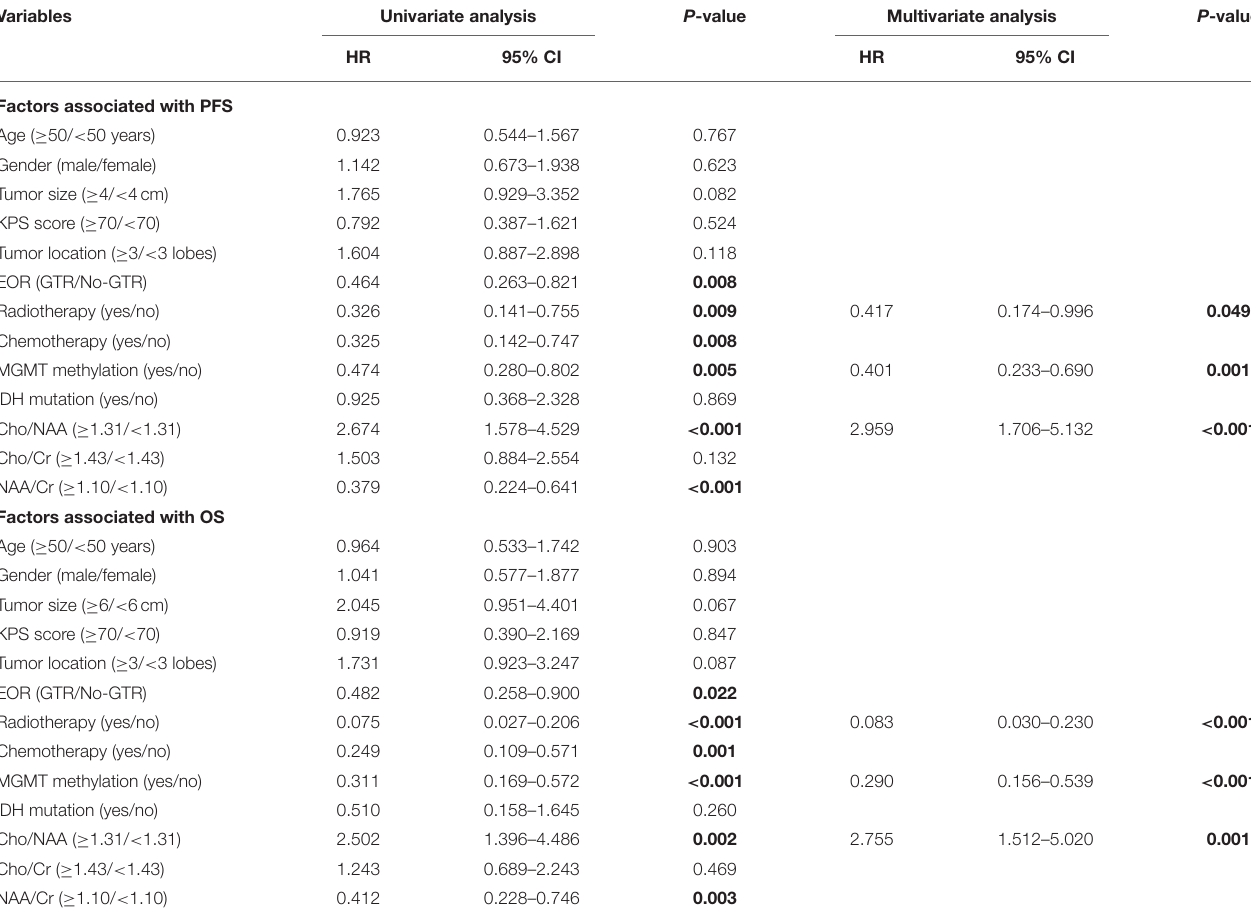
TABLE 2 | Univariate and multivariate survival analysis in all patients. Variables Univariate analysis P -value Multivariate analysis P -value